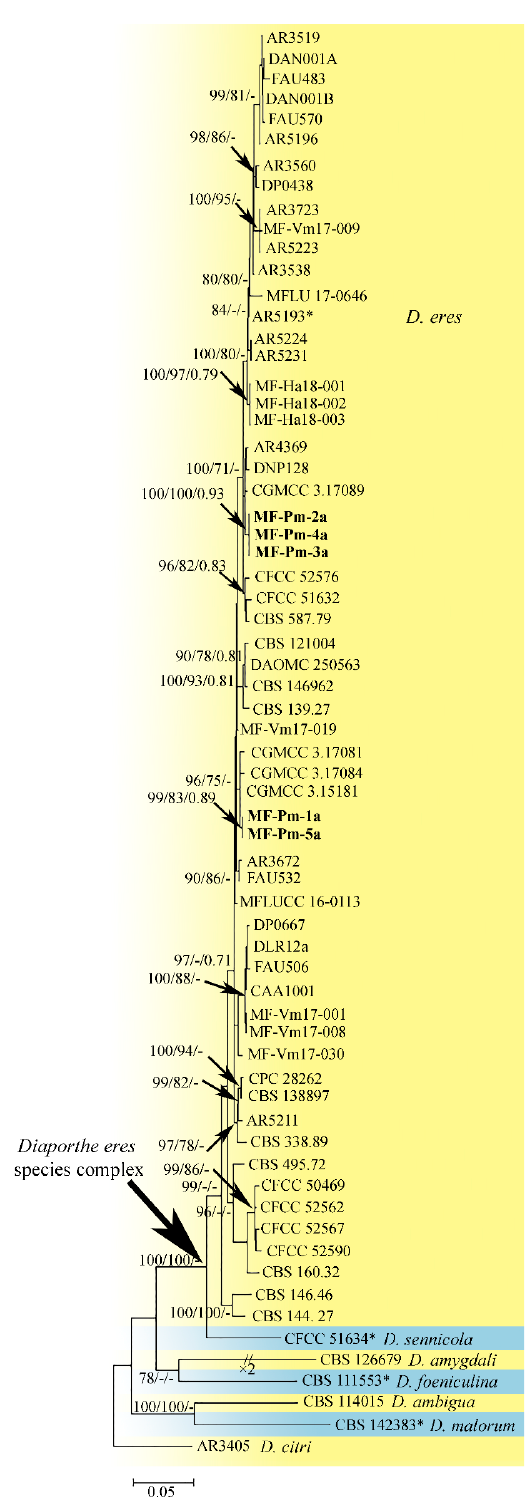
Figure 1. Phylogenetic tree of the Diaporthe eres species complex inferred from a maximum likelihood (ML) analysis based on a concatenated alignment of apn2 , tub2 , cal , and tef1- α . The ML bootstrap support values (MLBS ≥ 75), MP bootstrap support values (MPBS ≥ 75), and Bayesian posterior probabilities (BPP ≥ 0.75) are given at the nodes (MLBS/MPBS/BPP). Strains isolated in this study are indicated in bold. The ex-type strains are indicated with an